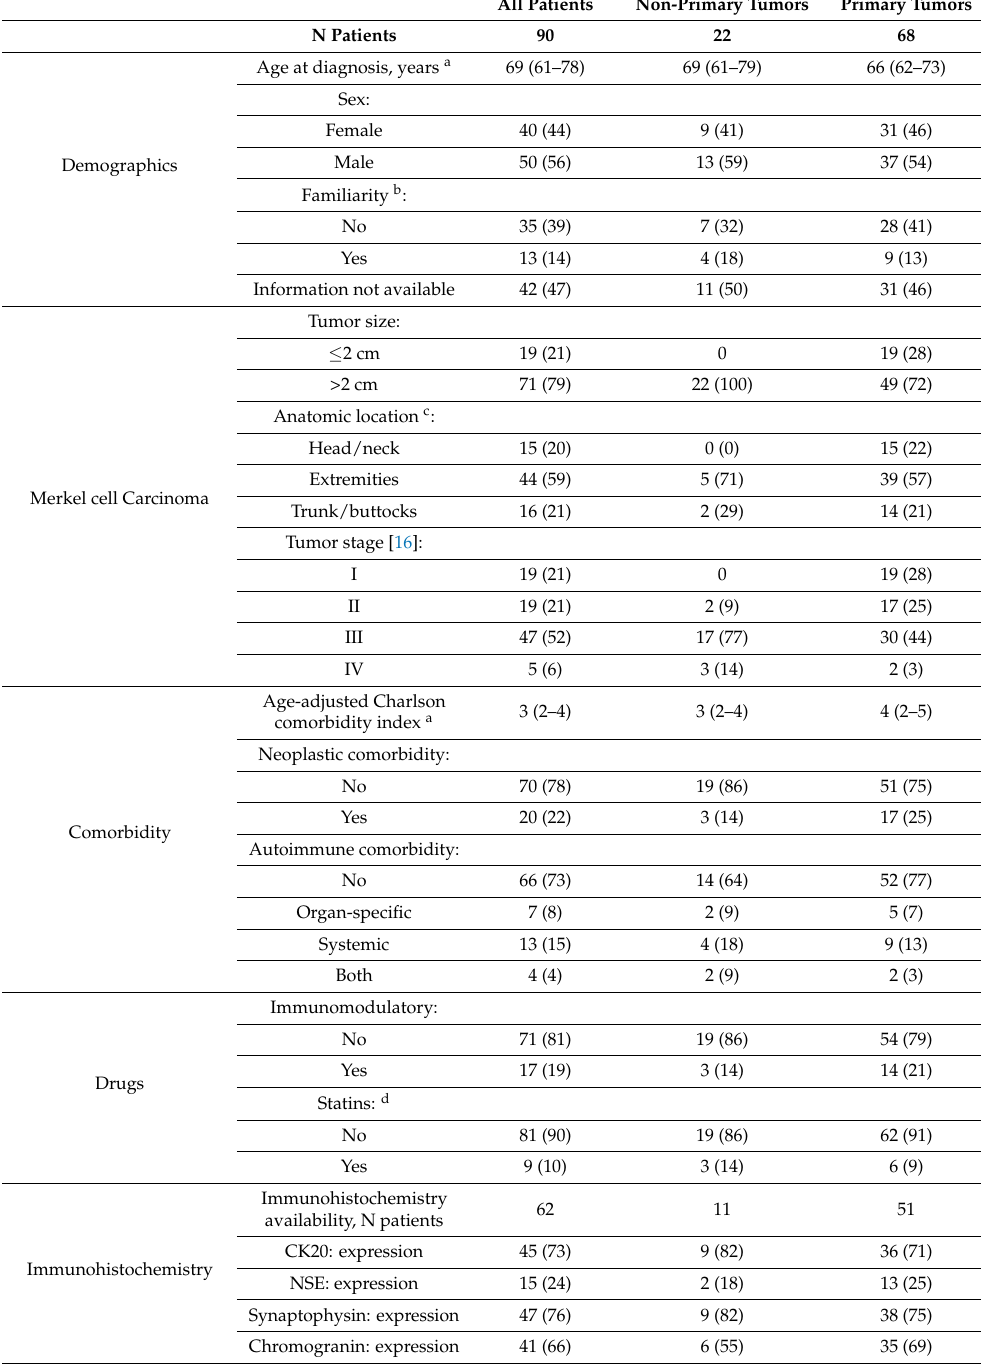
Table 1. Patient